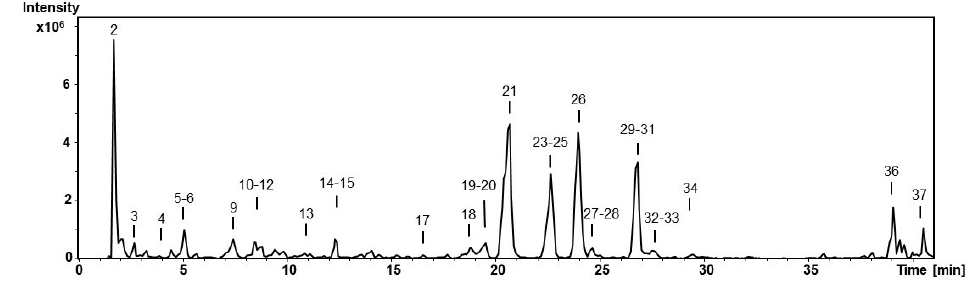
Figure 1. HPLC  ESI  MS n base peak chromatogram of food supplement S1. Figure 1. HPLC − ESI − MS n base peak chromatogram of food supplement